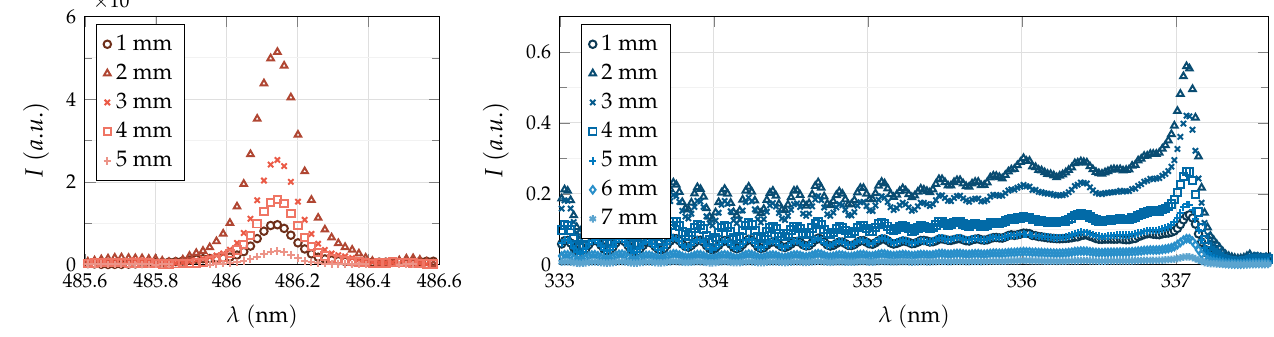
Figure 7. Experimental data used for estimation of n e (left hand-side) and T h (right hand-side). Due to imaging errors, a significantly lower intensity was recorded for a distance of 1 mm downstream from nozzle exit in both cases.